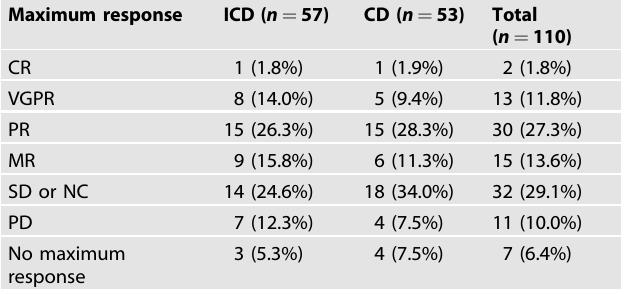
Table 2. Maximum response.